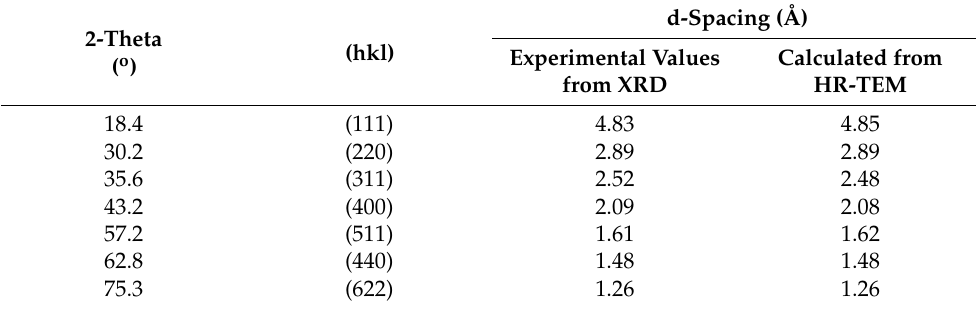
Figure 4. Images of the proposed HEMO3 material. ( a ) TEM image, ( b ) SAED pattern, and ( c ) HR-TEM image for the HEMO3 sample. Table 1. The d-spacing values for HEMO3 obtained from XRD and HR-TEM SAED